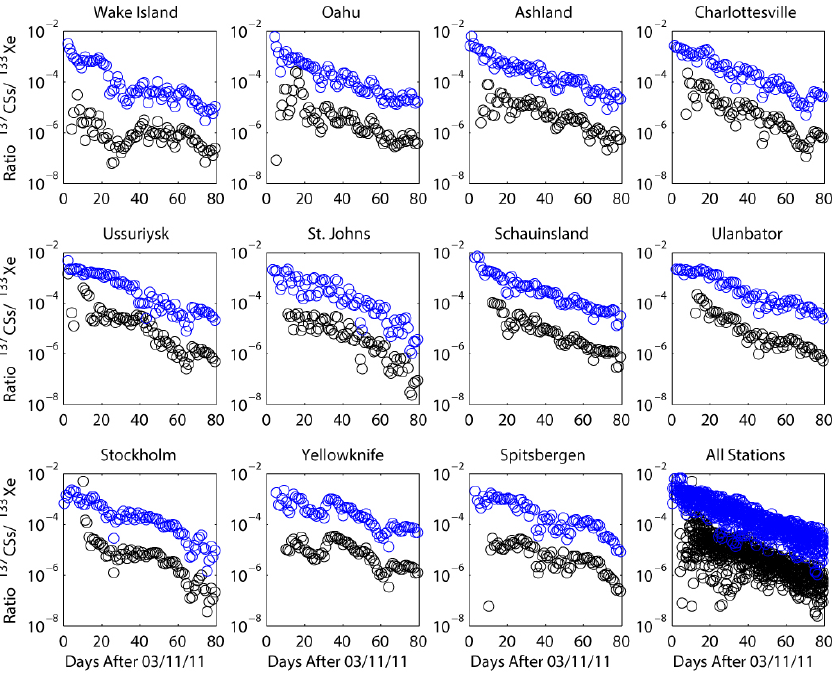
Fig. 4. Surface layer 137 Cs/ 133 Xe activity concentration ratio for the GEOS-Chem simulations CTL (black) and U7K (blue) as described in Table 1. The e-folding times and station latitude and longitude are shown in Table 3. Table 3. Surface layer activity concentration ratio ( 137 Cs/ 133 Xe) e-folding times ( τ e ) in days derived from measurements (Kristiansen et al., 2012) (square brackets indicate 95% confidence interval) and for the four simulations of this study described in Table